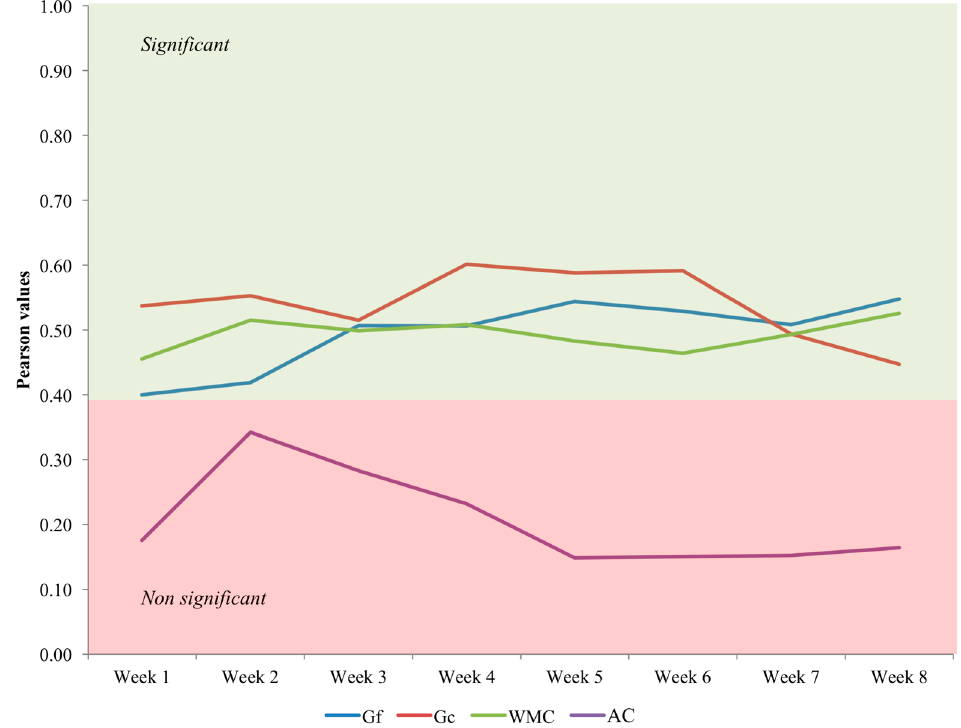
Figure 2. Correlations between baseline cognitive levels (Gf = fluid reasoning ability, Gc = crystallized ability, WMC = working memory capacity, AC = attention control) and adaptive dual n-back performance across weeks. The first four weeks were devoted to visual single n-back and auditory single n-back training.